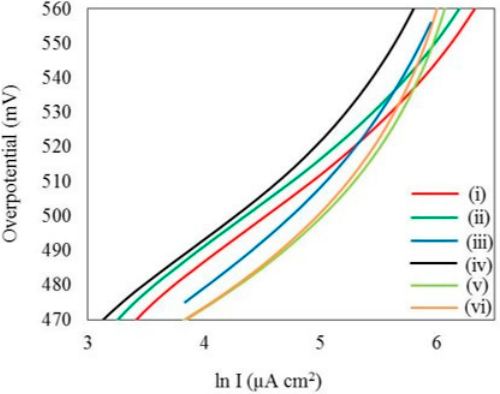
Figure 7. Tafel plots of (i) CaMn 2 O 4 nanowires/PPy (with light illumination), (ii) CaMn 2 O 4 nanowires/PPy (without light illumination, (iii) irregular-shaped CaMn 2 O 4 particles/PPy (with light illumination), (iv) irregular-shaped CaMn 2 O 4 particles/PPy (without light illumination) (dark), (v) PPy only (with light illumination) and (vi) PPy only (without light illumination).